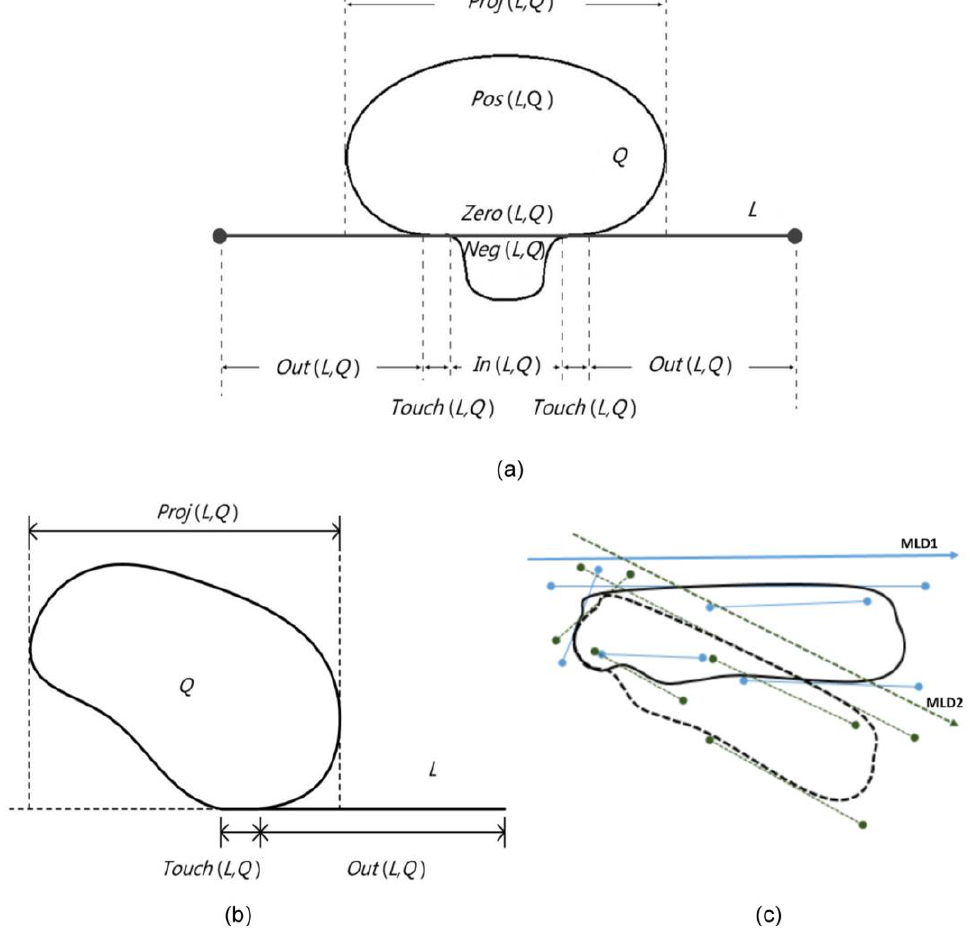
Figure 3. Region–line primitive association framework (RLPAF) modeling to time–phase region primitive and multitemporal line primitive. ( a ) RLPAF modeling. ( b ) A line touching the region. ( c ) Regions with apparent line direction changes.